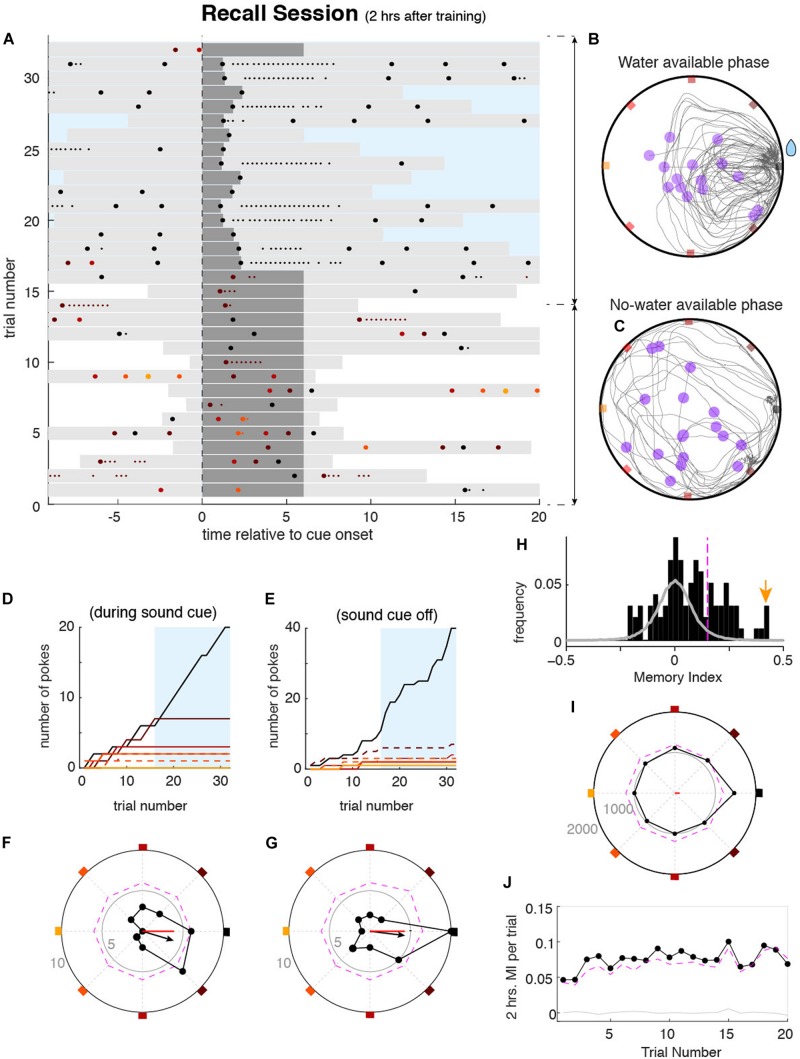
Mouse behavior during the memory recall sessions. (A) Pokes raster plot during an example memory recall session performed by mouse 4032, displayed as explained in Figure 2A. During recall sessions, correct pokes during the first n minutes of the session (n = 0, 1, 3, or 5) were not rewarded, to avoid re-learning of the reward location. Sound cues were never interrupted during this period. After the n minutes, correct pokes were rewarded as during the learning session (blue rectangle). In this example session, during the first n = 5 min, corresponding to trials 1–16, water was not available, whereas in trials 17–31 water was available. (B,C) All trajectories from all trials accumulated over the recall session for the period without water (F) and water (G). Representation is equivalent to that shown in Figure 2C. Cumulative poke count versus trial number for each port during sound cue (D) and sound cue off (E). Correct port (black) and one neighbor port (dashed brown) show higher poke count in both cue on and cue off conditions during the period without water. Once the water was available and harvested (blue area), the rewarded port was mostly poked. Poke histograms in polar coordinates for the example session (black dots), showing the number of pokes in each port as the radial distance of each point to the center, for the cue on (F) and cue off (G) conditions. Colored squares mark the angle of each port (as in Figure 1B). Small gray numbers show the count number of the radius of the inner and outer circles. The dashed magenta line shows the pointwise significance bound obtained from shuffled data (P < 0.01, one-tailed; see section “Methods”). Black arrows show the vector summation of the counts over all the ports. Red lines show the MI for the session relative to the 2 h correct port. (H) Histogram of MIs obtained from individual recall sessions of mouse 4032 (black bars). Gray histogram shows the MI values from the surrogate data set drawn from a uniform poking distribution. The magenta vertical line shows the significance bound of individual session MI (P < 0.01). The yellow arrow marks the session shown in (A–G). (I) Accumulated poke histogram for all sessions (n = 127) of mouse 4032 considering both on and off cue conditions. Magenta dashed line indicates significance bound (P < 0.01, one-tailed). The red line shows the MI over all sessions. (J) 2 h average MI versus trial index during the recall session. Despite the absence of water during these trials, MI was significantly larger than zero over the first 16 trials, illustrating the persistence of the animal to recall the rewarding port.